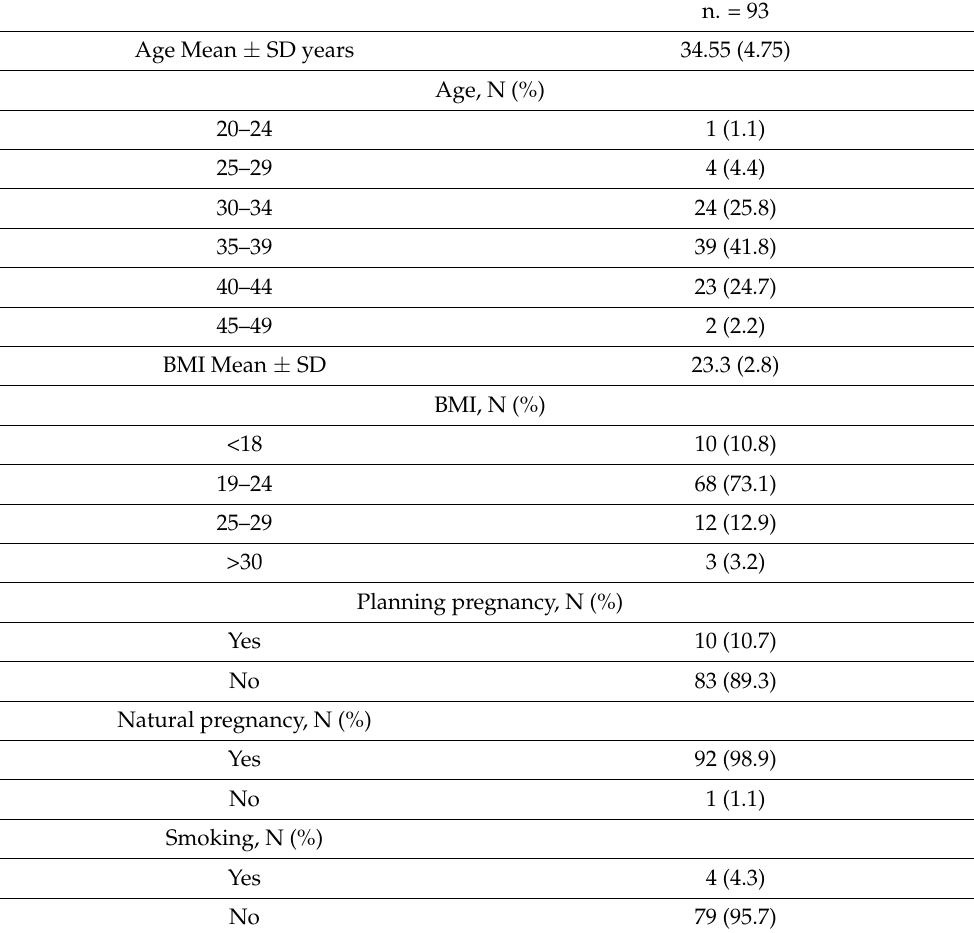
Table 1. Demographic characteristics of the 93 participants for validation of the PMI.